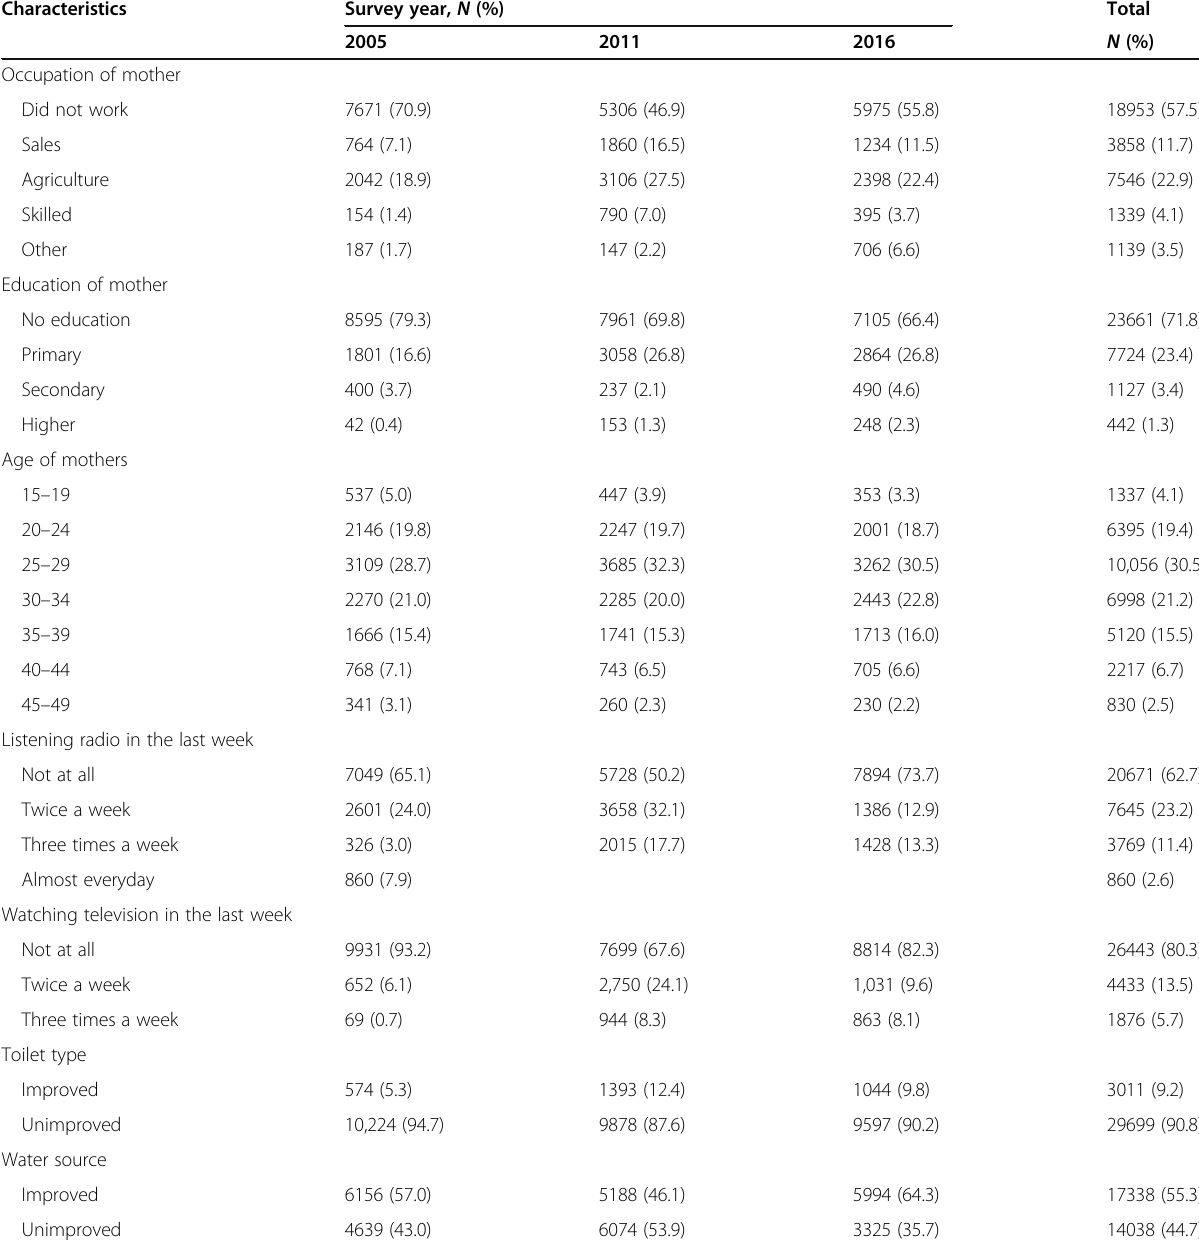
Table 1 Socio-demographics of households and under-five children characteristics, EDHS 2005 – 2016 (Continued)